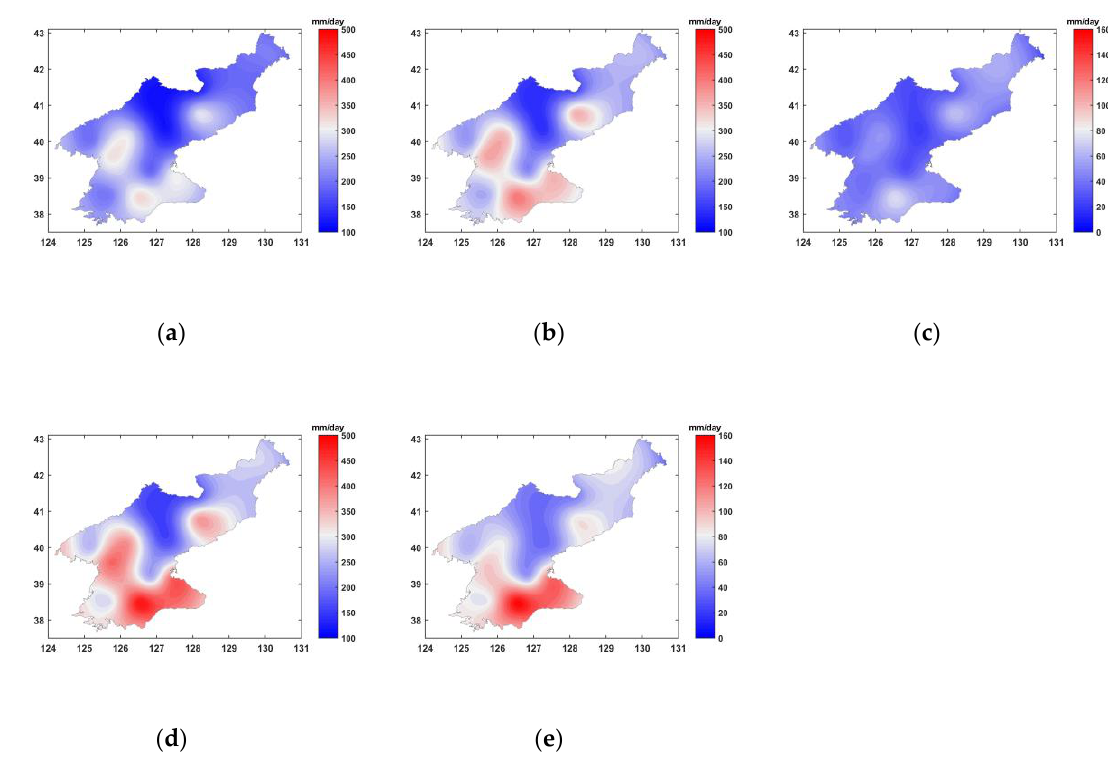
Figure 4. Change in 20-year precipitation (mm) for 25 CMIP5 GCMs for the reference period (Ref), F3, and the difference between F3 and Ref. ( a ) Ref, ( b ) F3 under RCP4.5, ( c ) F3 under RCP4.5 minus Ref, ( d ) F3 under RCP8.5, and ( e ) F3 under RCP8.5 minus Ref.